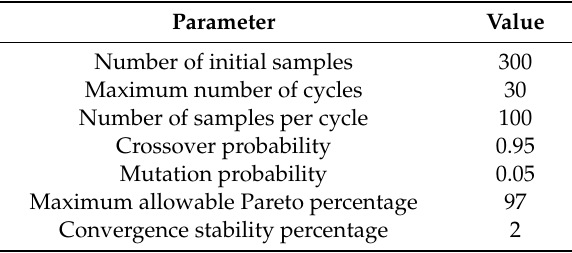
Table 3. Information of setting criteria for